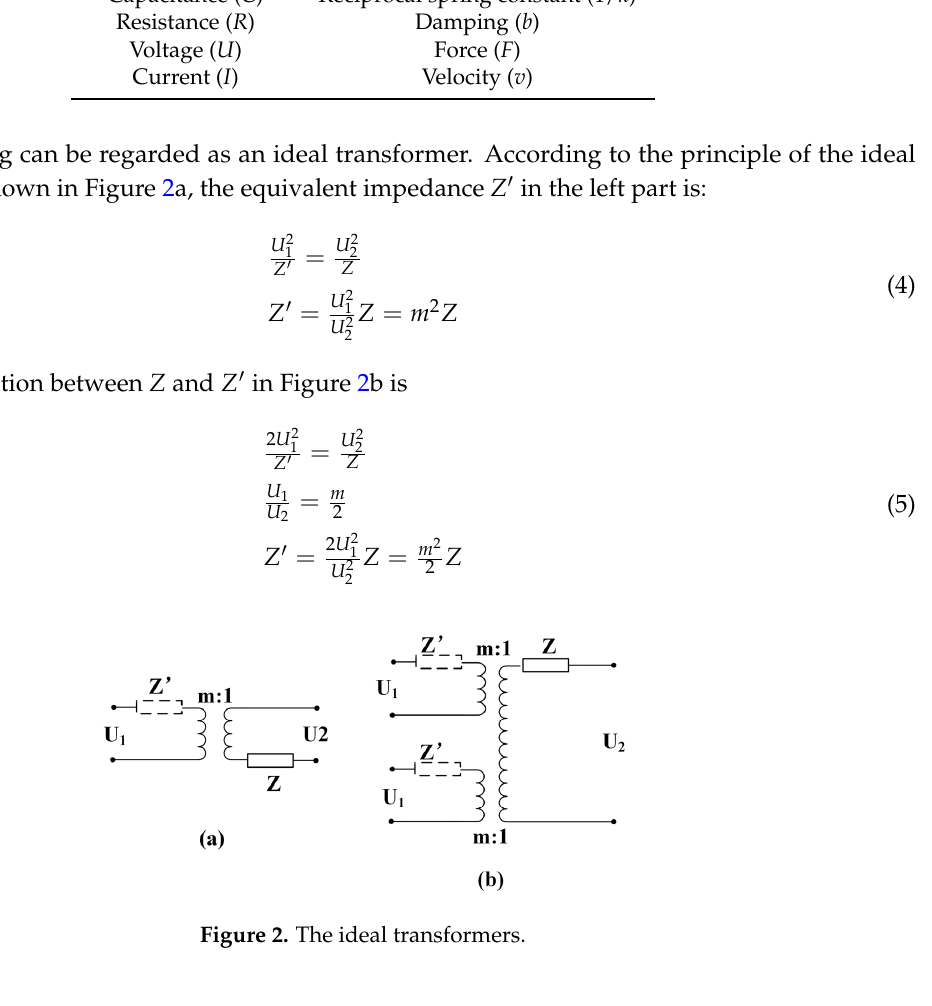
Table 1. The corresponding relationship of the electrical and mechanical parameters.